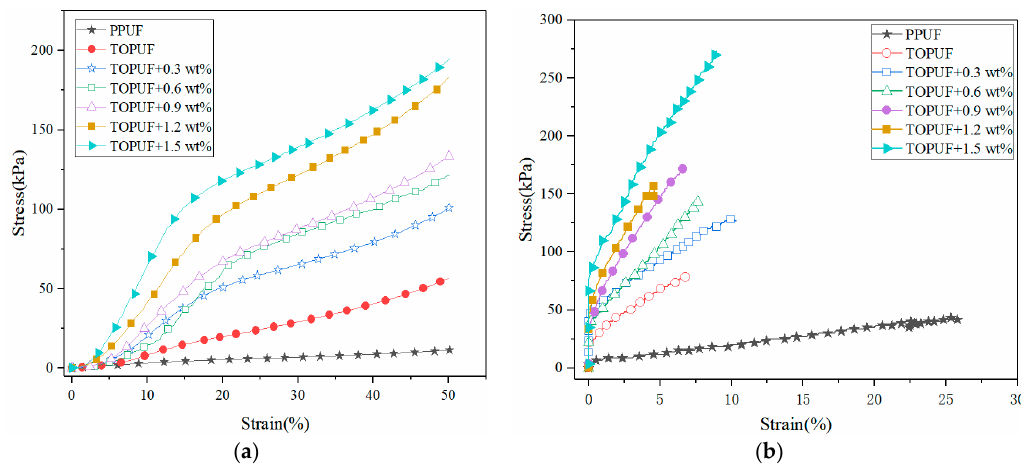
Figure 15. Stress-strain curves for compression ( a ) and tensile ( b ) of TOPUF adding different mass of ML powders.